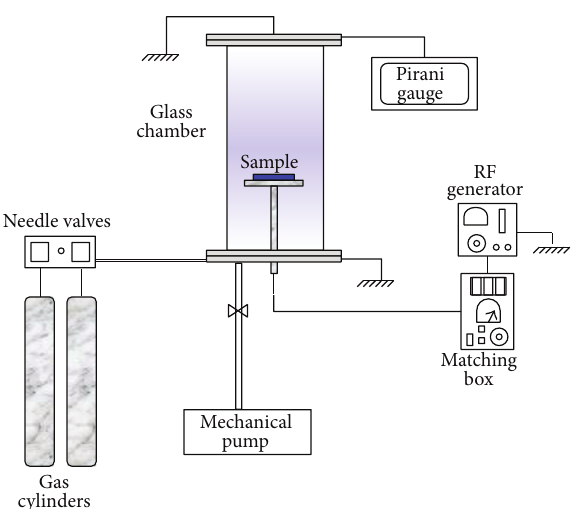
Figure 1: Experimental apparatus employed to deposit films onto the PVC